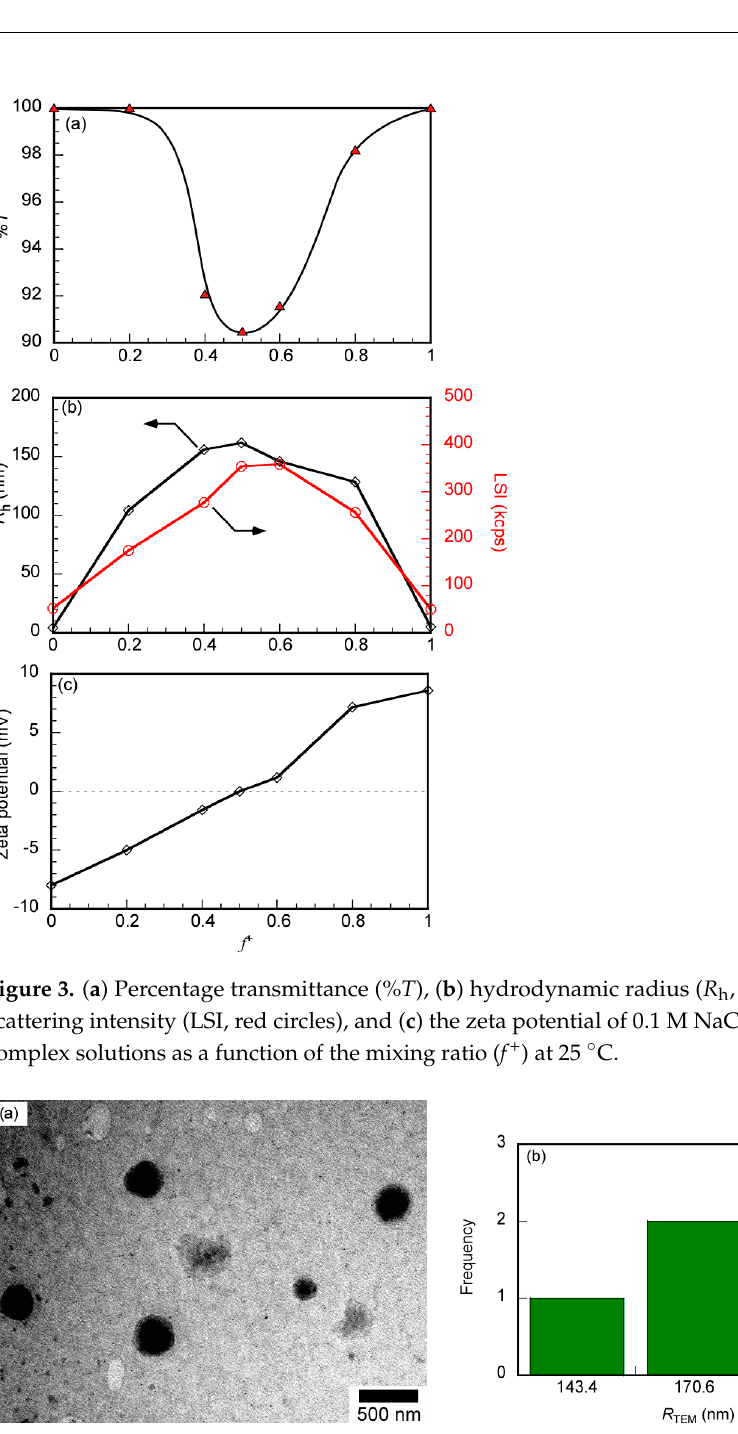
Figure 4. ( a ) TEM image and ( b ) histogram of particle size distribution of PSBP/CTAB complex with a mixing ratio of 0.5 within a complex concentration of 0.084 g/L in a 0.1 M NaCl aqueous solution.